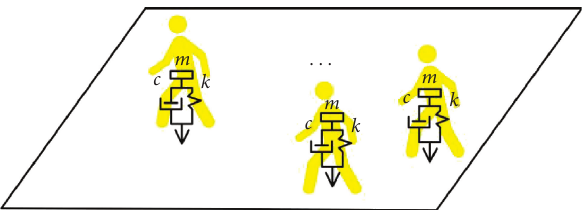
Figure 4: Schematic diagram of human-structure interaction. Table 1: Human-induced vibration test